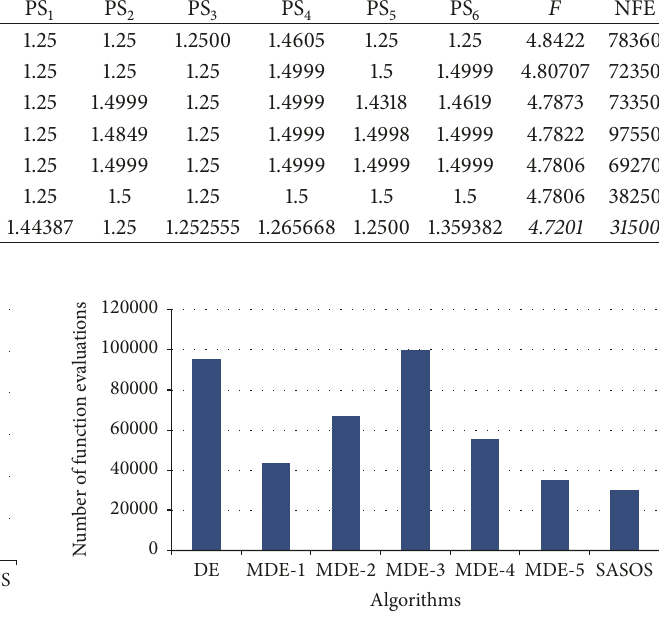
Figure 6: Comparison of number of function evaluations done, for obtaining the best results, by SASOS algorithm with DE and its modified versions for 4-bus model.